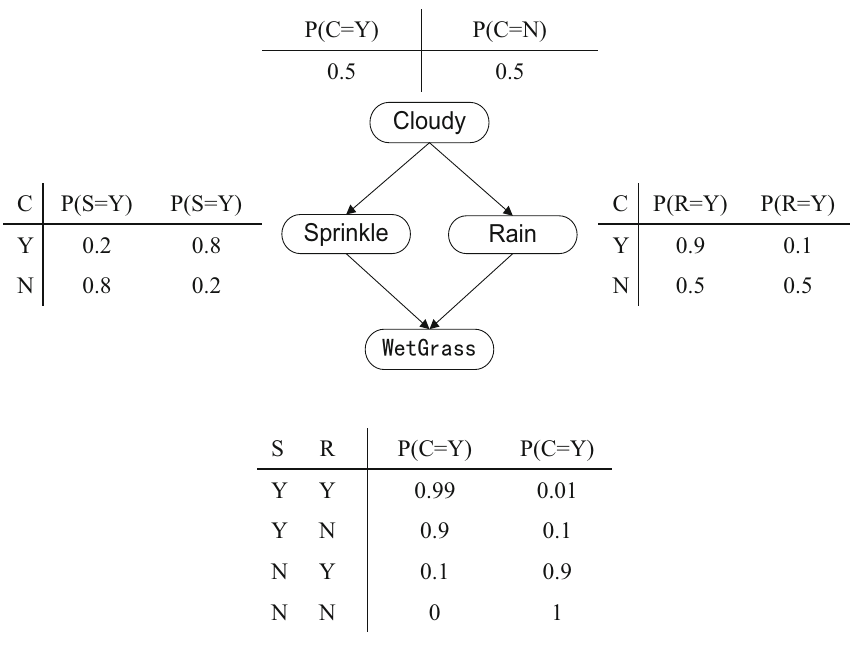
Fig. 3 ‘‘Wet Grass’’ Bayesian